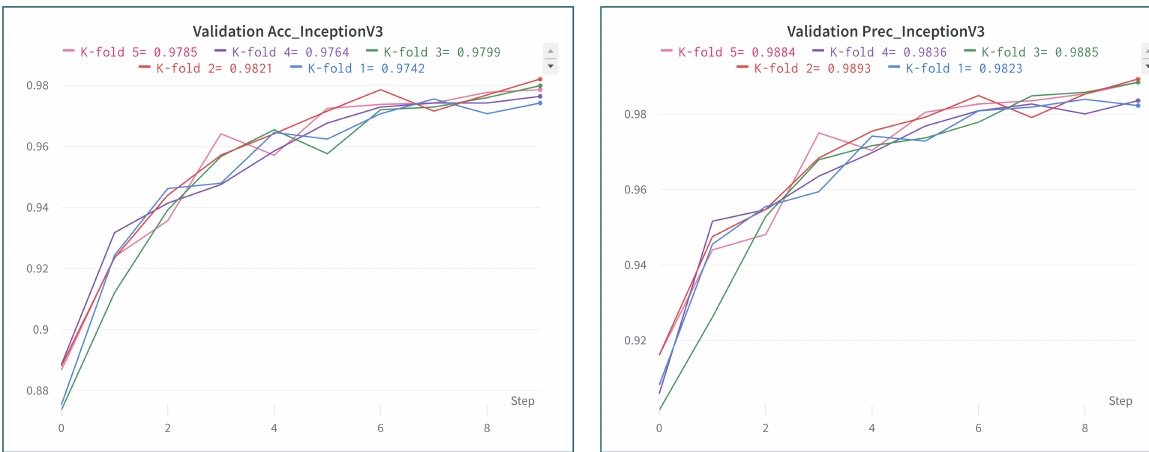
Figure 10. Validation Accuracy and Precision of the InceptionV3 model.